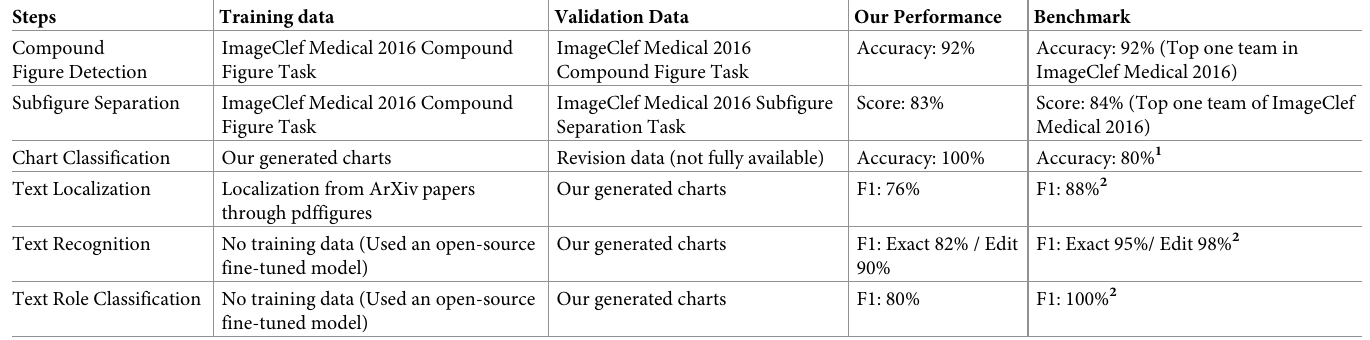
Table 1. Summary of Training and Validation for Image Preprocessing. 1 [53], 2